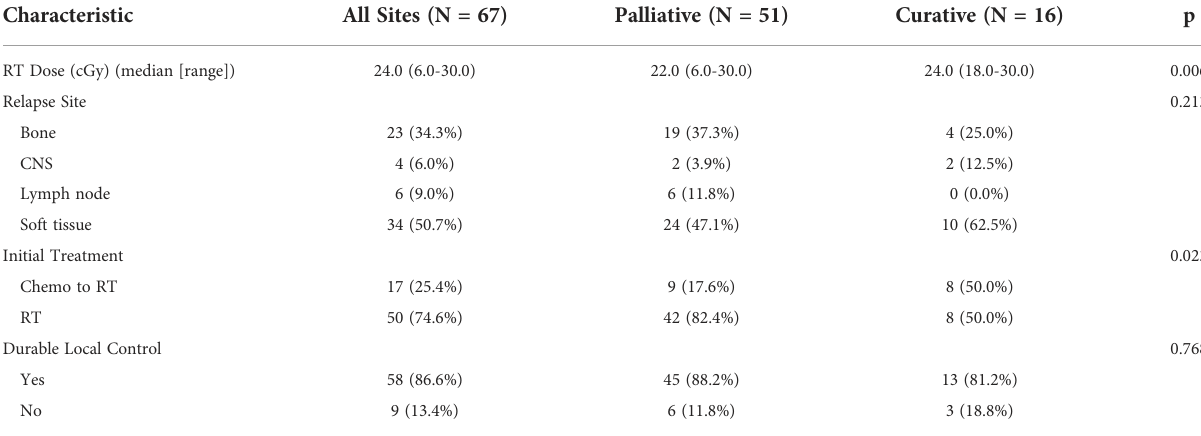
TABLE 2 EM Relapse